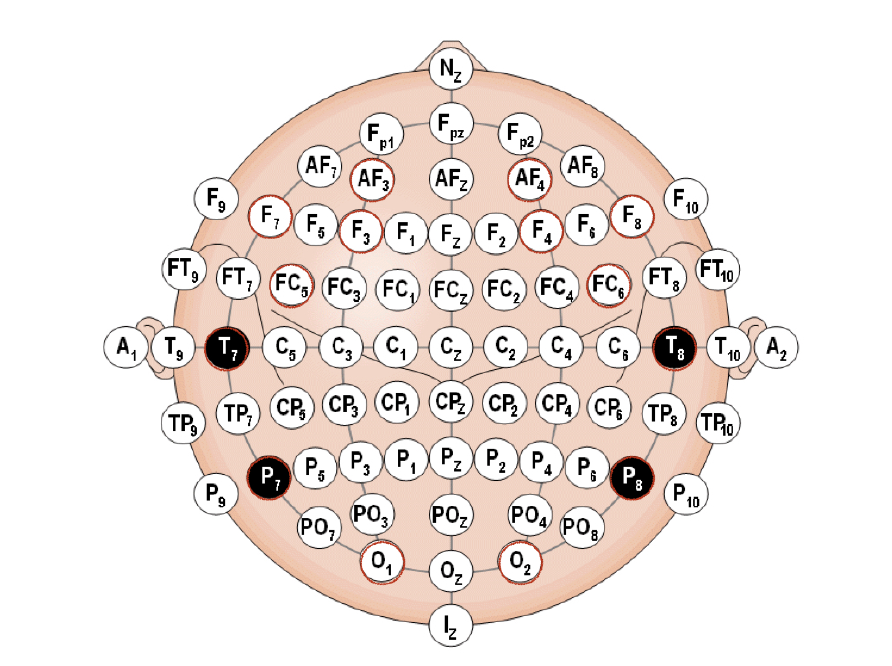
Figure 3. AES EEG electrode standardized